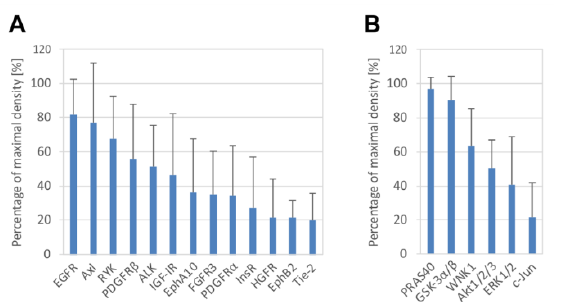
Figure 5. Phosphorylation analysis of RTKs and downstream signaling proteins in GCTB-derived cell lines. Highly phosphorylated RTKs ( A ) and downstream signaling proteins ( B ) are displayed. The cutoff level was set as 20% of maximal density. Phosphorylated proteins are arranged in order of percentage of maximal density. The data represent the mean of values of five ( A ) or six ( B ) analyzed cell lines ± SD.